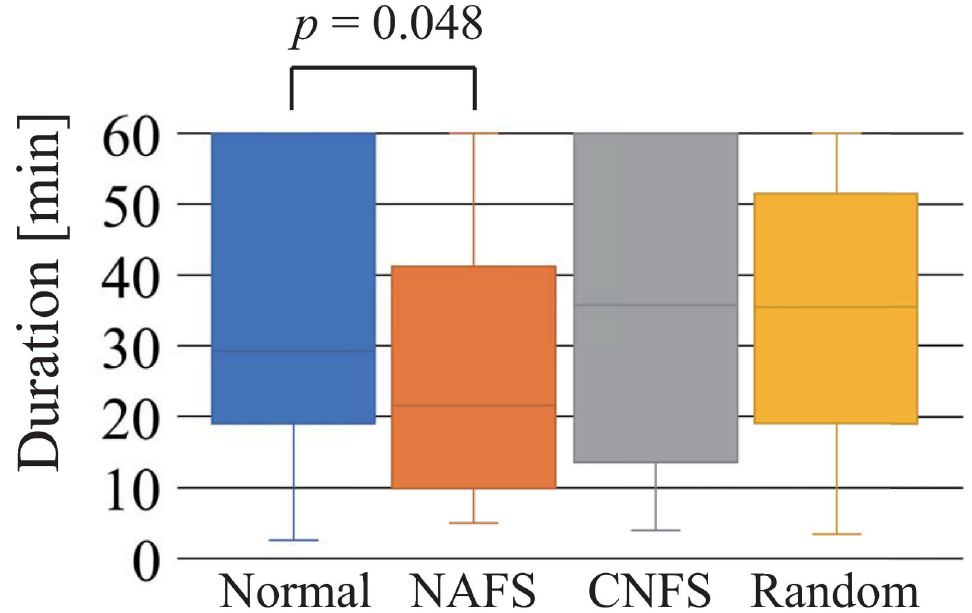
Fig 7. Duration required to achieve the terminal condition. This indicates a certain level of understanding of the operation. Normal, NAFS, CNFS, and random indicate the normal, “name appears after the first success,” “change to normal controller after the first success,” and random controllers,